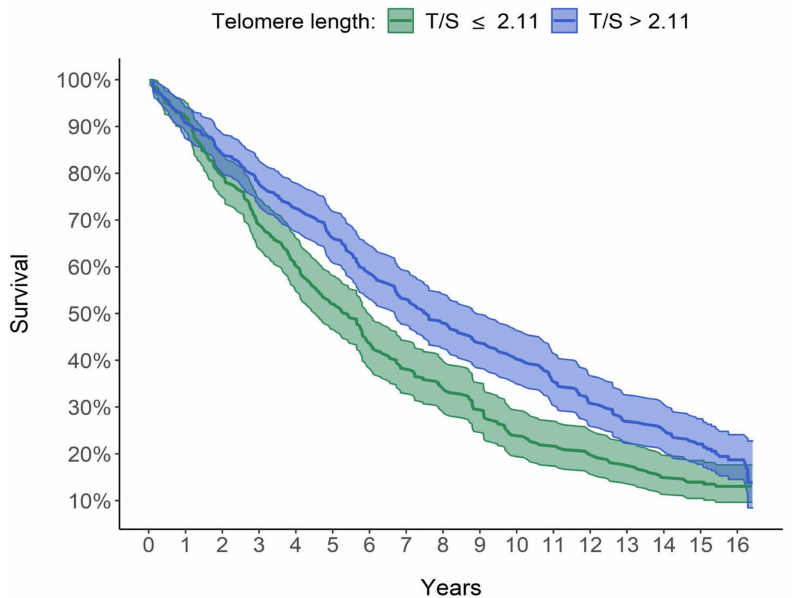
Figure 3. Graphic comparison of the survival of the 2 groups. Survival curves estimated using Kaplan–Meier method. The median survival time is 5.41 years for subjects with T/S ≤ 2.11 and 7.57 years for subjects with T/S >